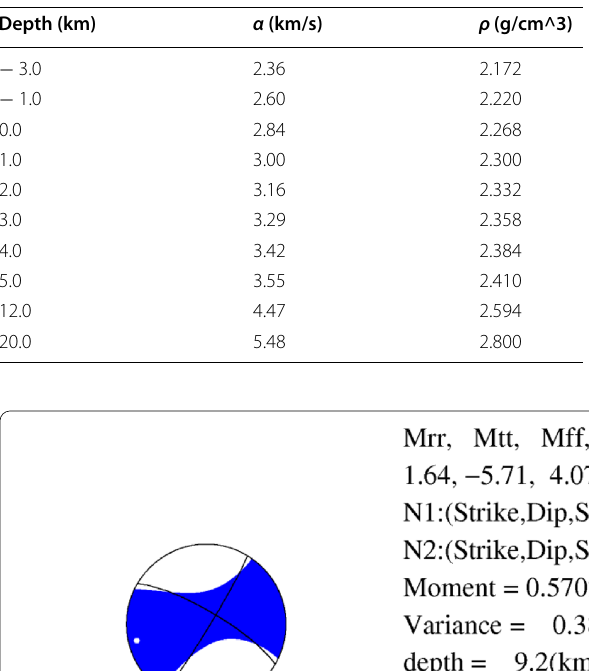
Table 2 The 1D velocity model used in this study for initial hypocentre determination (from Indrastuti et al., 2019). The α β ratio is assumed to be 1.73